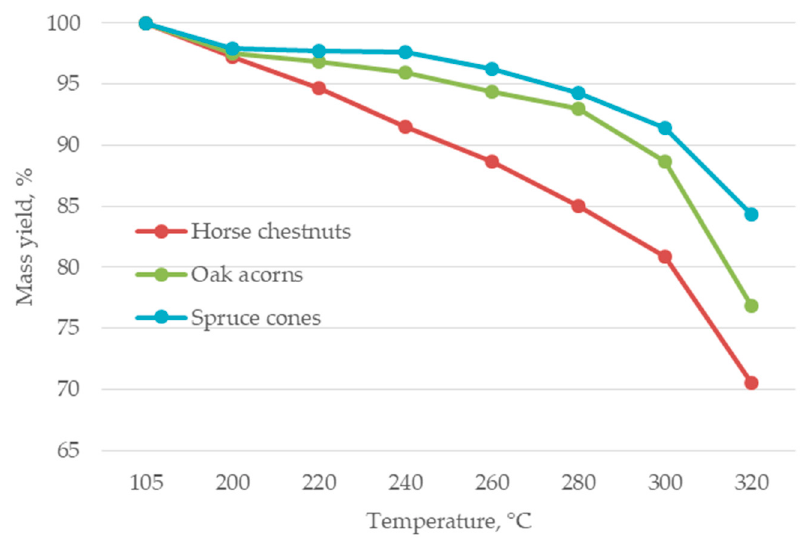
Figure 14. Mass yield of the torrefied forestry biomass.